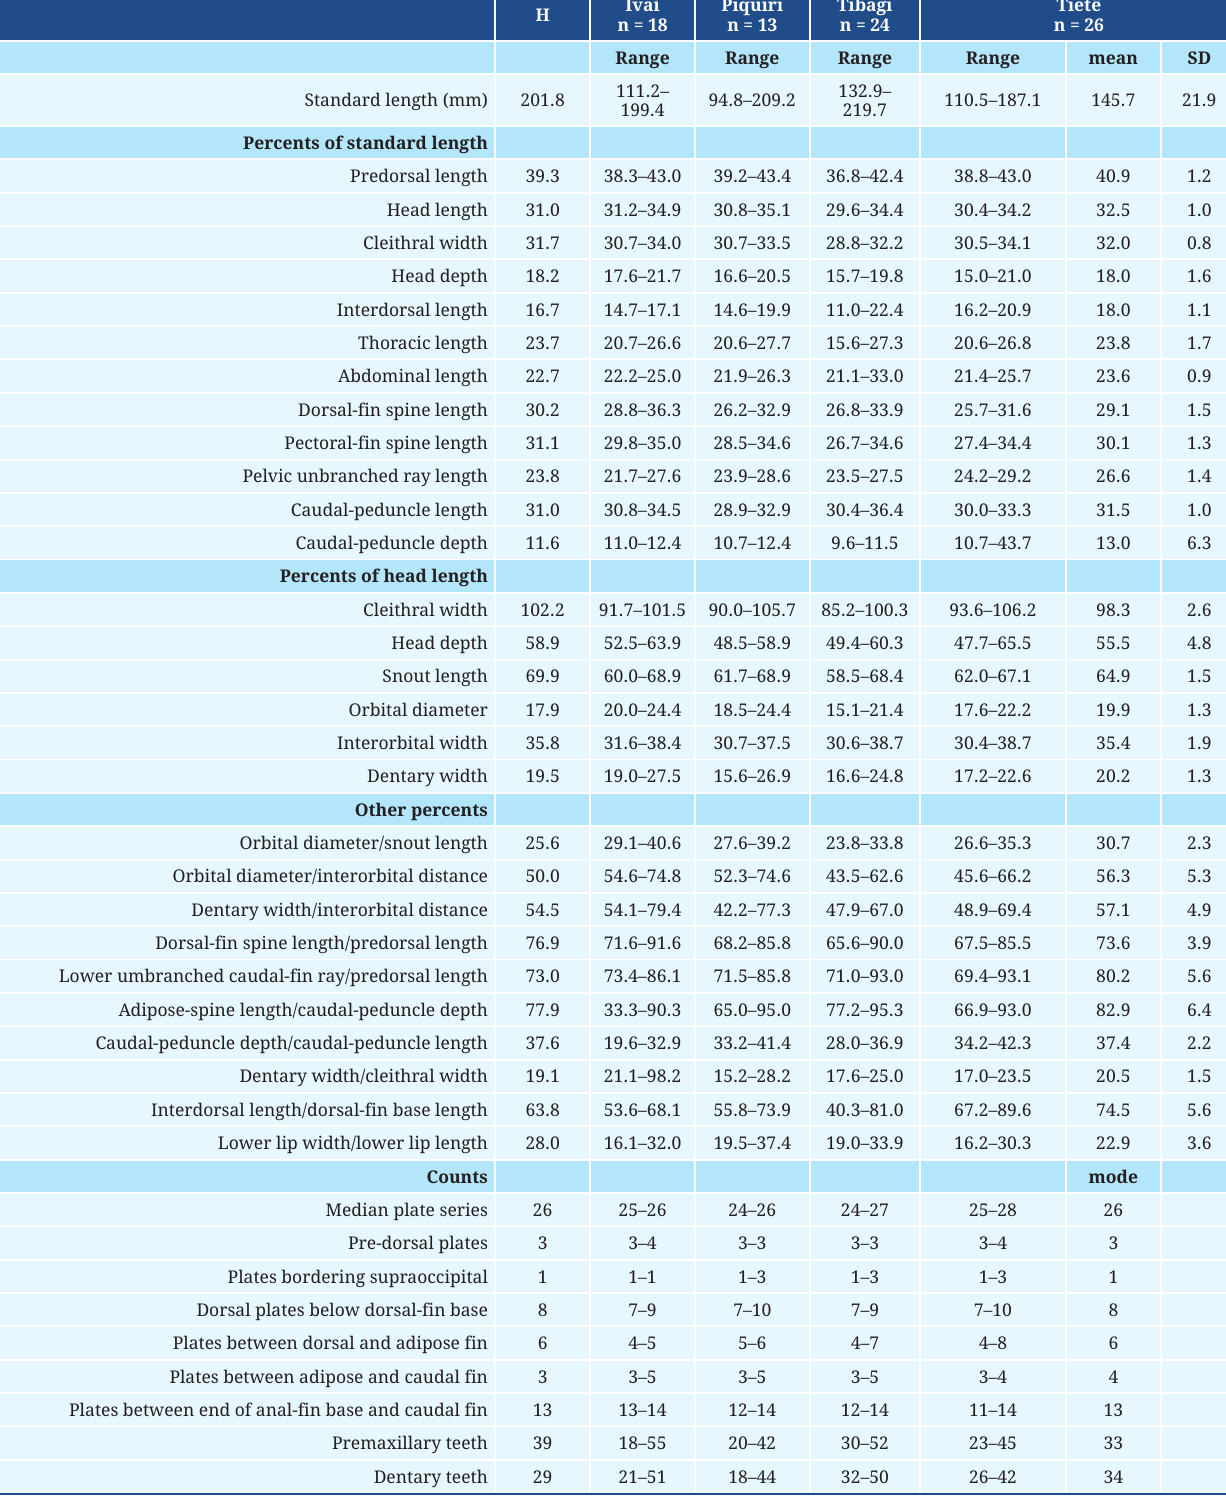
TABLE 1 | Counts and morphometric data of Hypostomus hermanni from the Ivaí, Piquiri, Tibagi and Tietê river basins. H, holotype; SD, standard deviation; n = number of